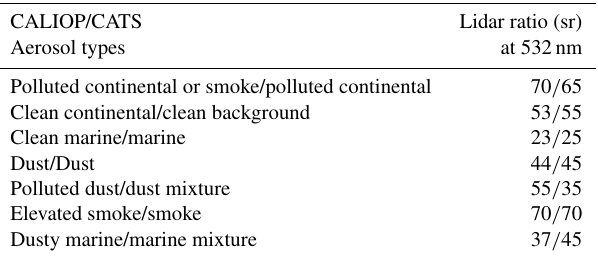
Table 2. LR corresponding with the CATS- and CALIOP-derived aerosol